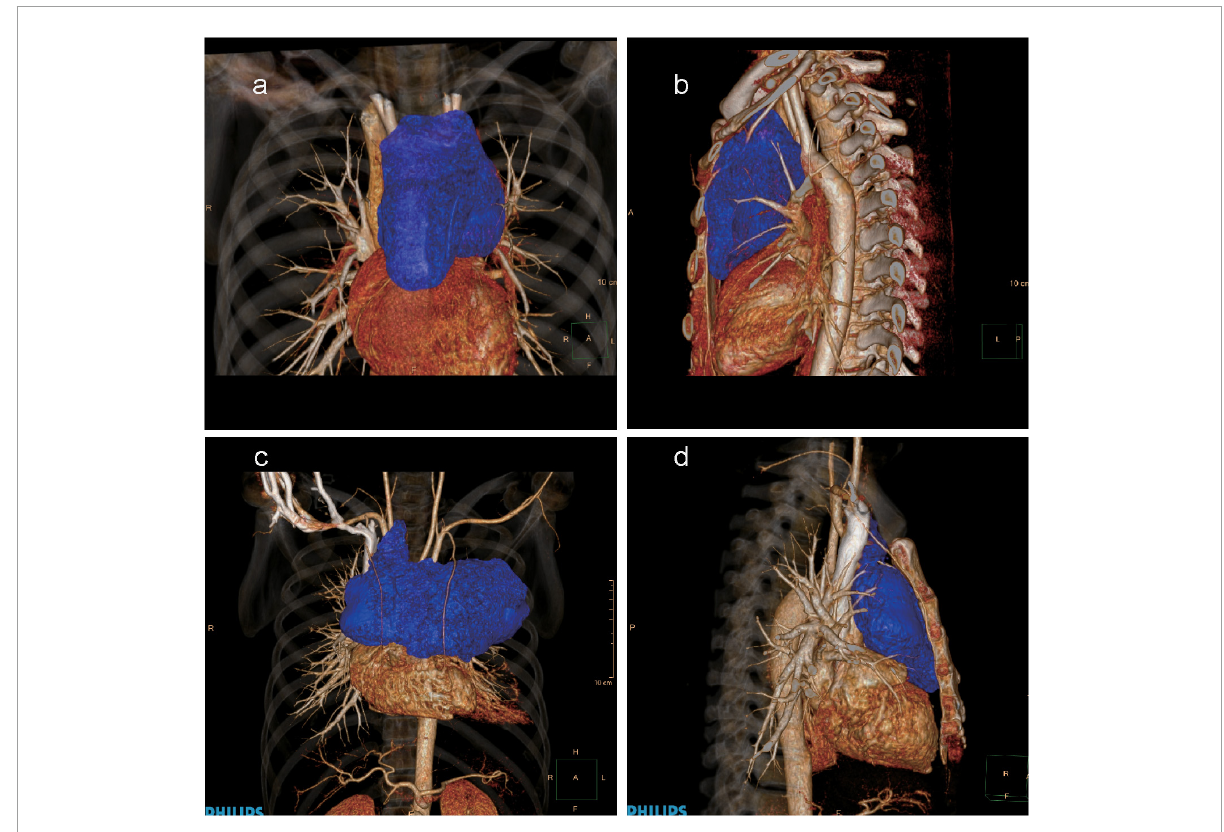
FIGURE1 Three-dimensional computed tomography (CT) images of the large anterior mediastinal mass. (a) The anteroposterior CT image of the first patient (tumor represented in blue). (b) The lateral CT image of the first patient (tumor represented in blue). (c) The anteroposterior CT image of the second patient (tumor represented in blue). (d) The lateral CT image of the second patient (tumor represented in blue).